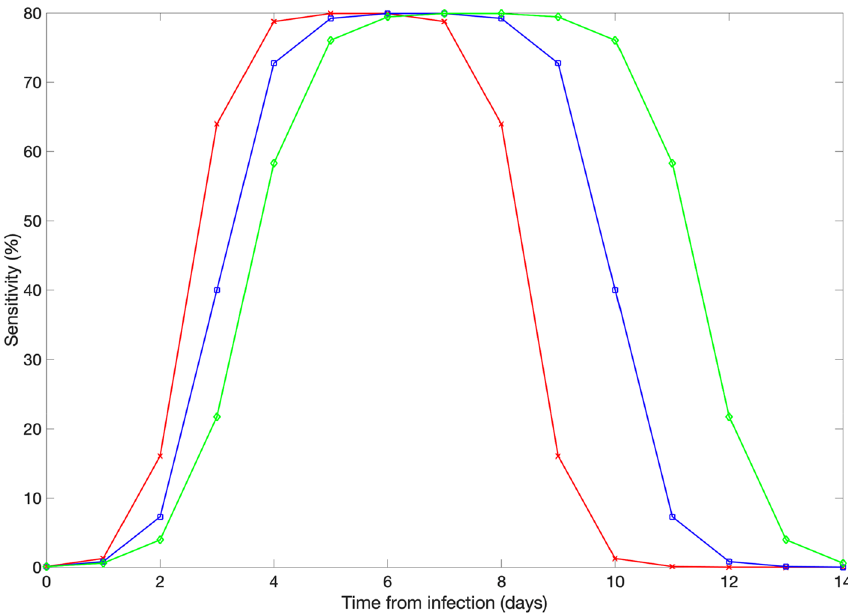
Figure 3. Illustration of the PCR test sensitivity profiles modeled according to a logistic function where a peak sensitivity of 80% is reached 5 (red curve), 6 (blue curve), or 7 (green curve) days post